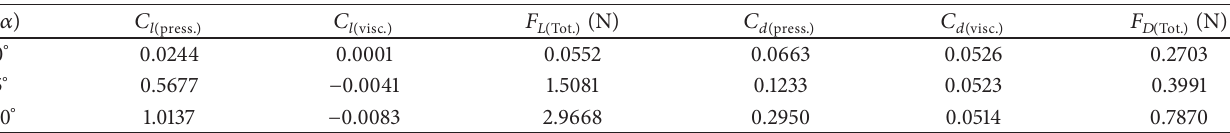
Table 4: Rostrum lift and drag components pertaining to the contributions from pressure and viscous forces, as well as the integrated total lift and drag force over the entire rostrum surface (see (2)-(3)).